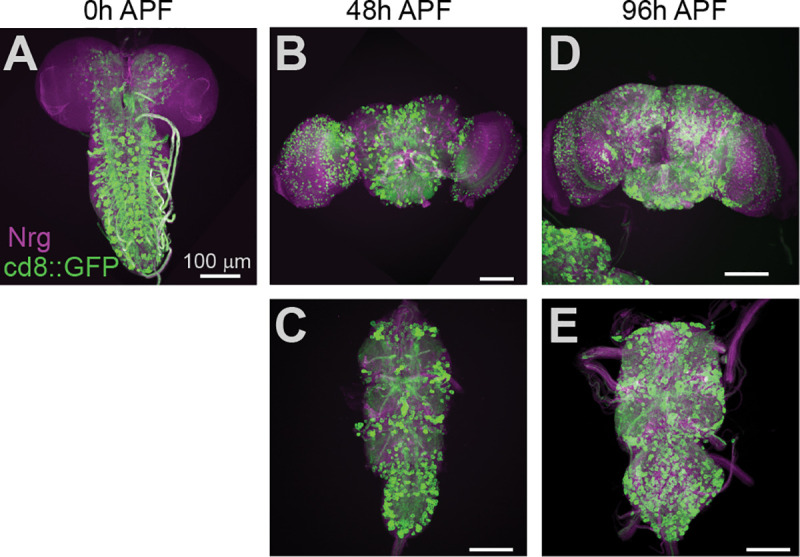
Octopamine-tyramine receptor+ cells are abundant throughout development.(A) Maximum-intensity projection of oct-tyrR+ neurons (green) and anti-neuroglian (Nrg) (magenta) immunostaining in the 0-hr pupal nervous system. (B) 48-hr pupal brain. (C) 48-hr pupal VNS. (D) 96-hr pupal brain. (E) 96-hr pupal VNS. APF: after puparium formation.